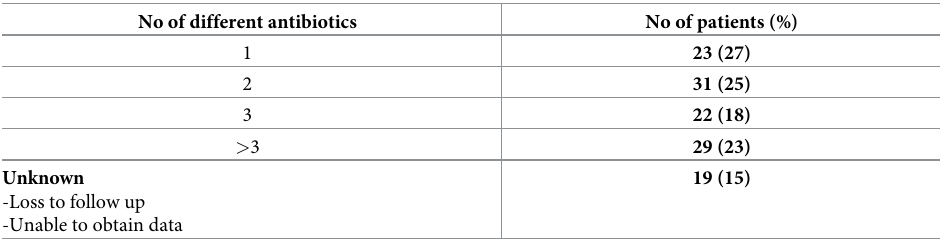
Table 3. Number of antibiotics used per